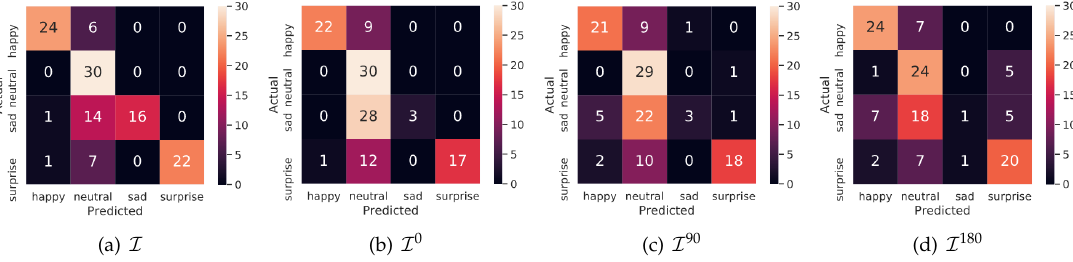
Figure 9. Confusion matrices of facial expression recognition using MS Azure face API: ( a ) result of original images, ( b ) result of reconstruction images (i.e., rotated with 0 degrees), ( c,d ) results of de-identification images by rotating 90 and 180 degrees, respectively.